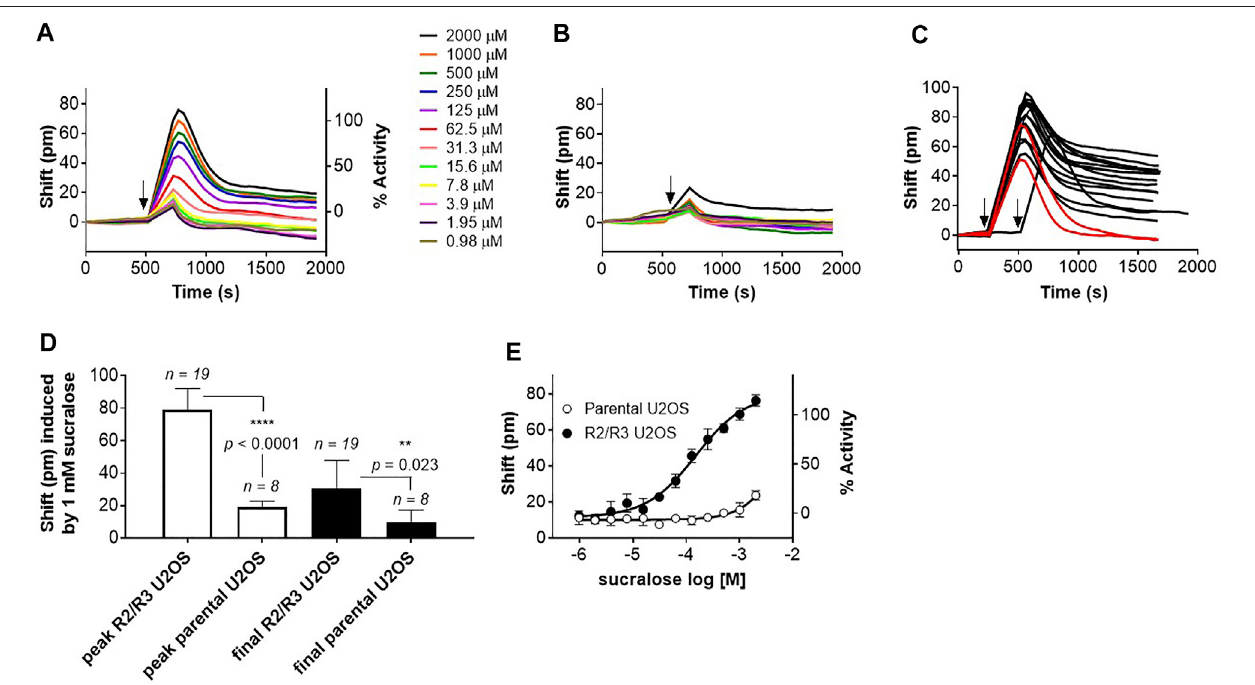
FIGURE 2 | Development of a DMR assay for the human sweet taste receptor. (A) Application of increasing concentrations of sucralose onto R2/R3 U2OS cells cause a positive DMR signal. Arrow indicates time of application. (B) Application of increasing concentrations of sucralose onto parental U2OS cells does not cause a comparable positive DMR signal. Arrow indicates time of application. (C) Kinetics of sucralose (1 mM)-induced DMR responses over a period of 3 months. 19 independent experiments wereconducted duringthat period.In 2ofthese experiments (red traces) theDMR responses returnedtobackgroundlevelswhilein the remainingexperimentstheystayedabovebackgroundlevels.Arrowsindicatetimeofapplication. (D) Determinationofassaywindowrobustnessatthepeakor fi nalDMR responses. A maximum concentration of sucralose (1 mM) was used to stimulate either R2/R3 U2OS cells or parental U2OS cells (number of independent experiments are indicated on the bar graph). Peak and fi nal DMR responses were recorded and averaged. Data shows that measurement at the peak response provides a better assay window (unpaired, t -test, α = .05). (E) Representative sucralose dose-response analysis on R2/R3 U2OS cells and parental U2OS cells. Dose-response is representative of several independent experiments and each data point corresponds to an average and standard deviation of a triplicate determination. Averaged potency value for sucralose is summarized in Table 1